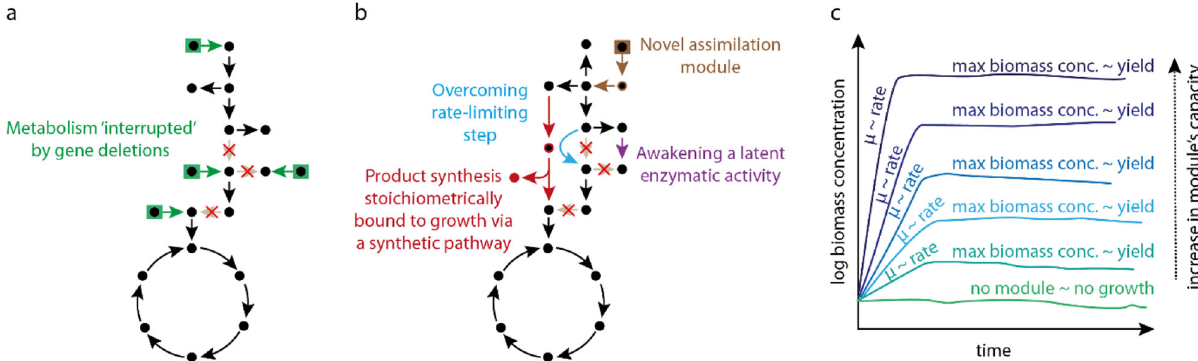
Fig. 1 Schematic representation of the metabolic network of growth-coupled selection strains and their role as proxy for determining rate and yields. Black circles represent essential intermediates that act as biomass precursors. a Selection strain, where gene deletions “ slice ” metabolism and microbial growth becomes dependent on the supplementation of external substrates (green boxes). b Possible use of selection strains for testing different types of metabolic modules. This representation condenses all module types that can (independently) rescue growth. Each arrow color represents a particular type of module that can be screened via this approach: (i) novel assimilation route (brown); (ii) metabolic bypass for avoiding a rate-limiting step (light blue); (iii) exploration of latent promiscuous enzymatic activities (purple); and (iv) (synthetic) pathway that also produces a compound of interest (red). c Module activities will result in growth of the selection strain; monitoring biomass formation provides information related to rates and